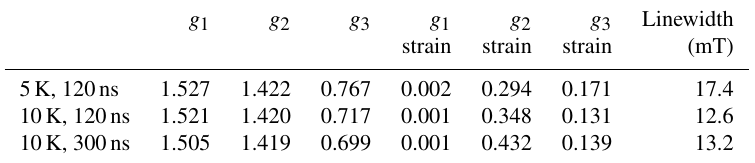
Table B1. Best fit parameters for the NO@C60-OH3 spectra measured at different temperatures (data not shown). g